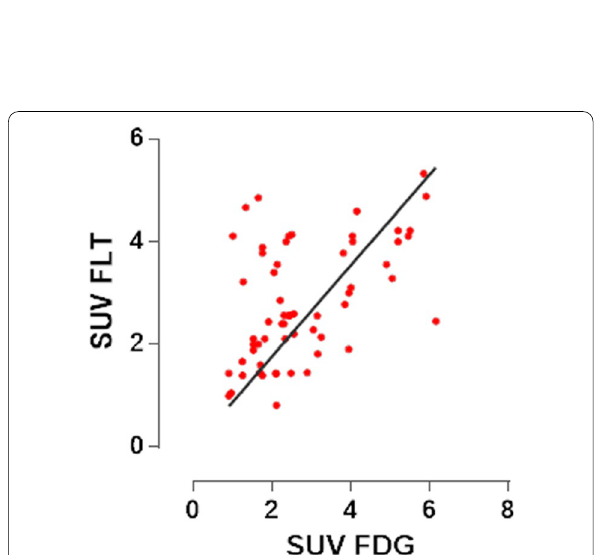
Fig. 2 Lesion‑per‑lesion comparison of blood‑pool corrected FLT and FDG SUVs. The linear regression equation was Y